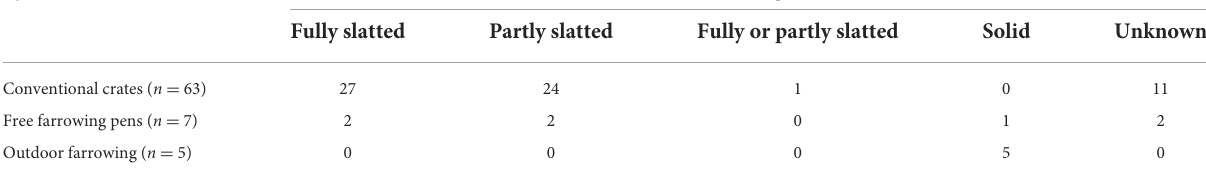
TABLE 5 Counts of farrowing system, flooring and use of enrichment reported by